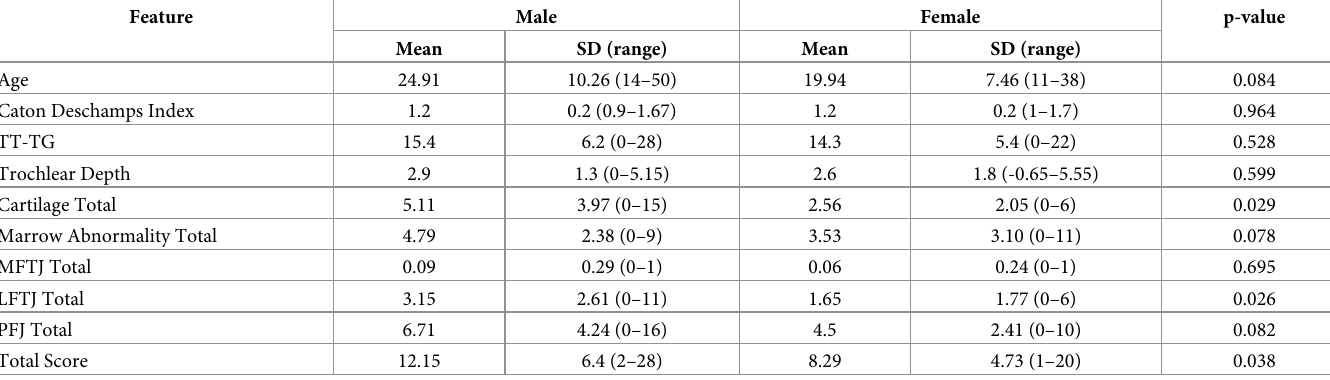
Table 5. Comparison of WORMS scores between male and female patients.